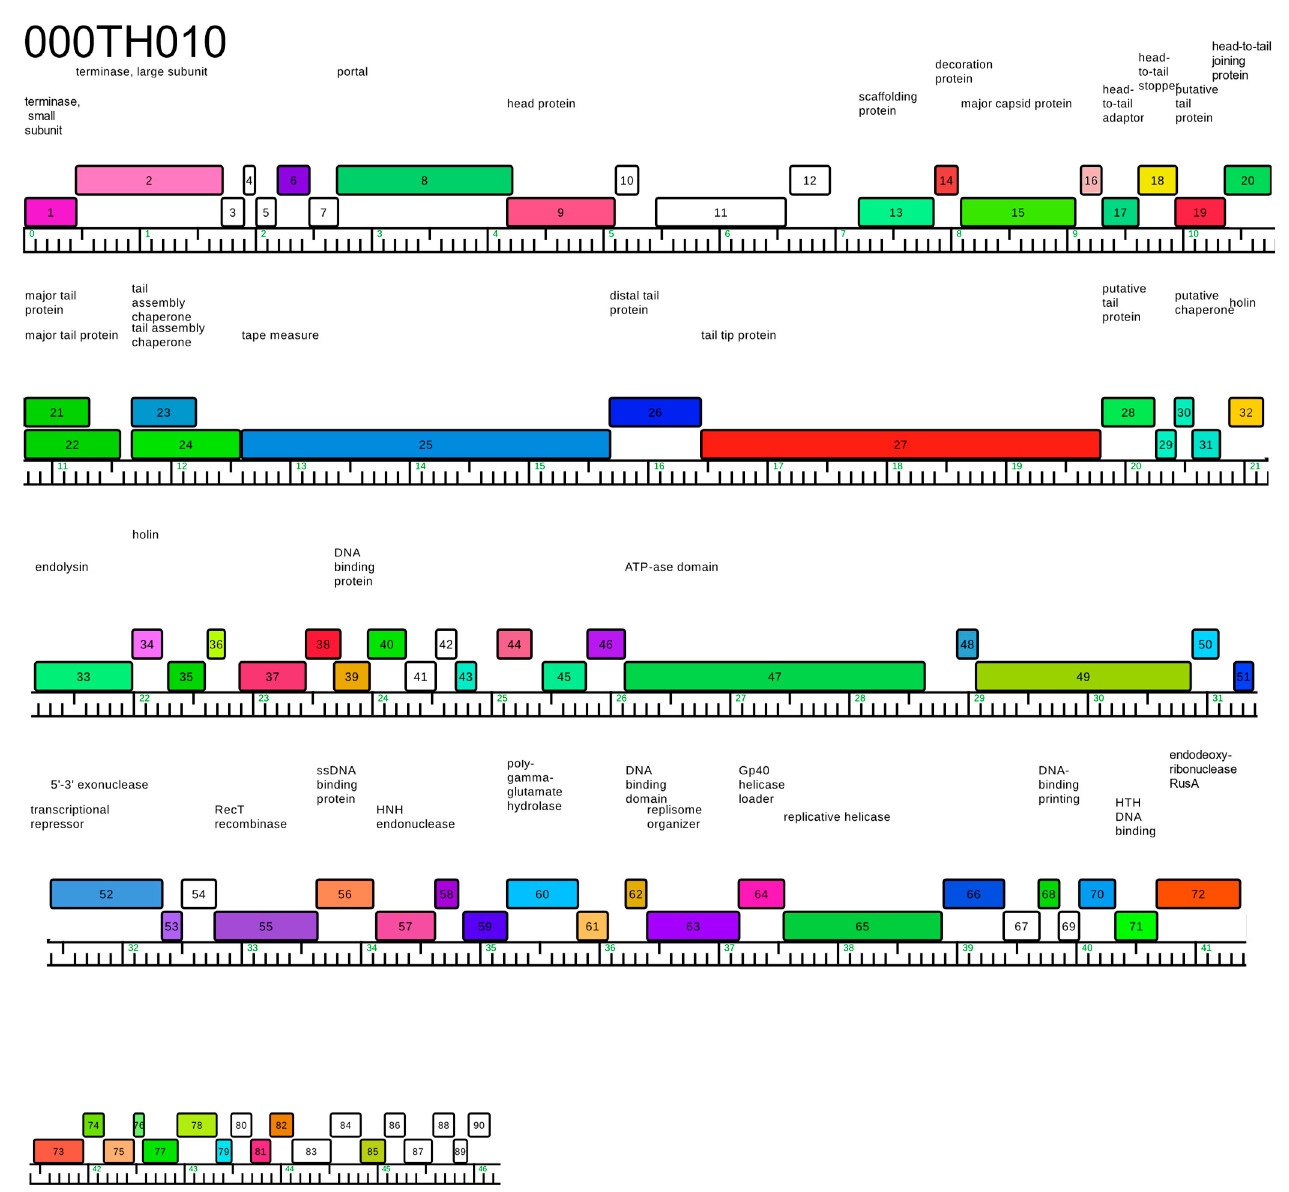
Figure 1. ( A ) Dot plot of the genomes of our three newly isolated SPP1 ‐ like phages as well as of SPP1. Plot created using Gepard [49]. ( B ) Average nucleotide identity (ANI; above the diagonal) and average amino acid identity (AAI; below the diagonal) for the SPP1 cluster phages, with each phage compared to the other phages. ANI and AAI were calculated using algorithms from [48].